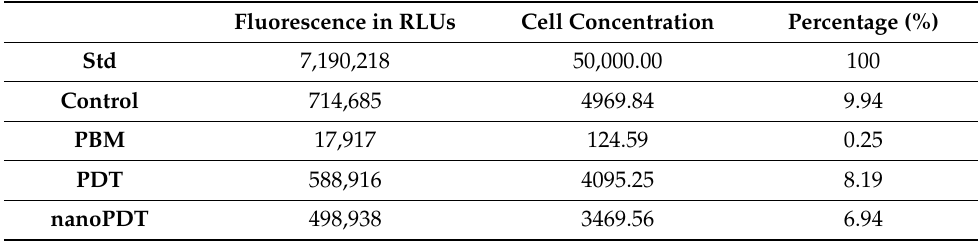
Table 2. ECM data of A549 lung cancer cells 24 h post-PDT treatment. The standard (Std) was obtained using the initial cell seeding concentration of 5 × 10 4 that represents 100% cell invasion. The concentration of cells that passed through the ECM were calculated, as was the percentage of cells that passed through the ECM compared to the